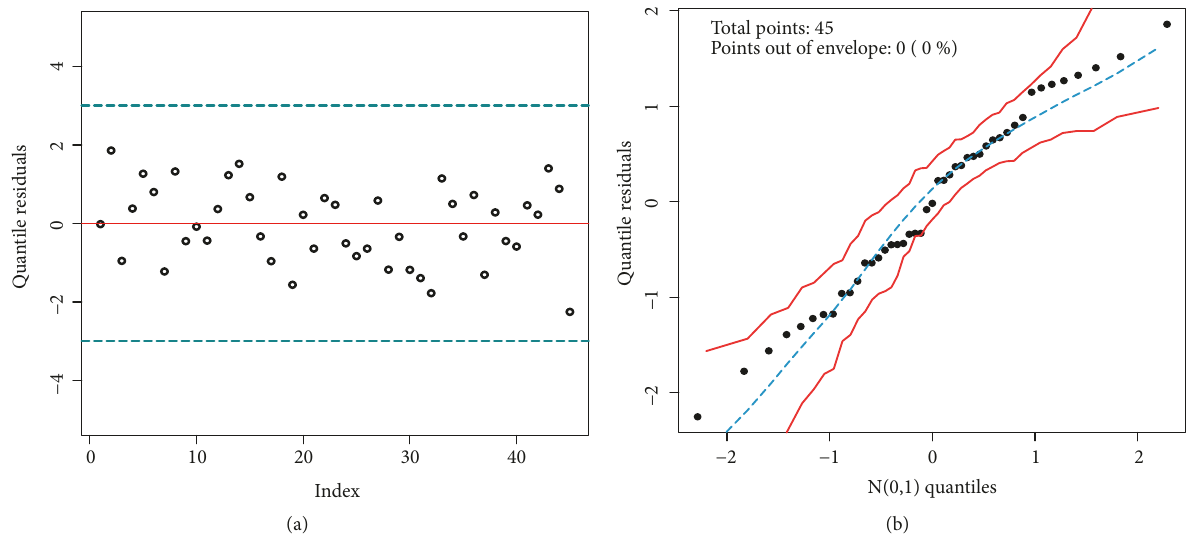
Figure 9: (a) Index plot of the qrs and (b) normal probability plot with envelope for the qrs from the fitted OLLGIG regression model fitted to urban property